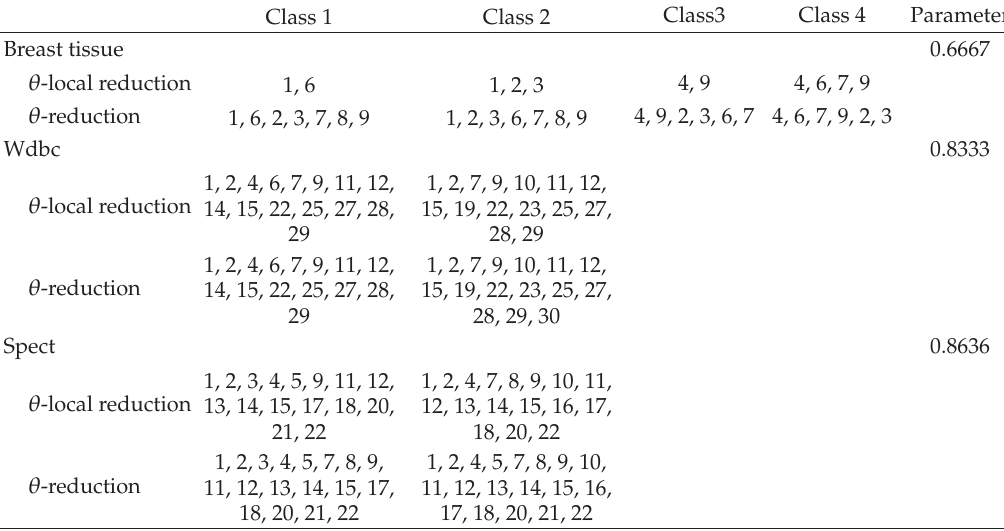
Table 4: The comparisons on selected attributes between θ -local reduction and θ -reduction. Class 1 Class 2 Class3 Class 4 Parameter Breast tissue